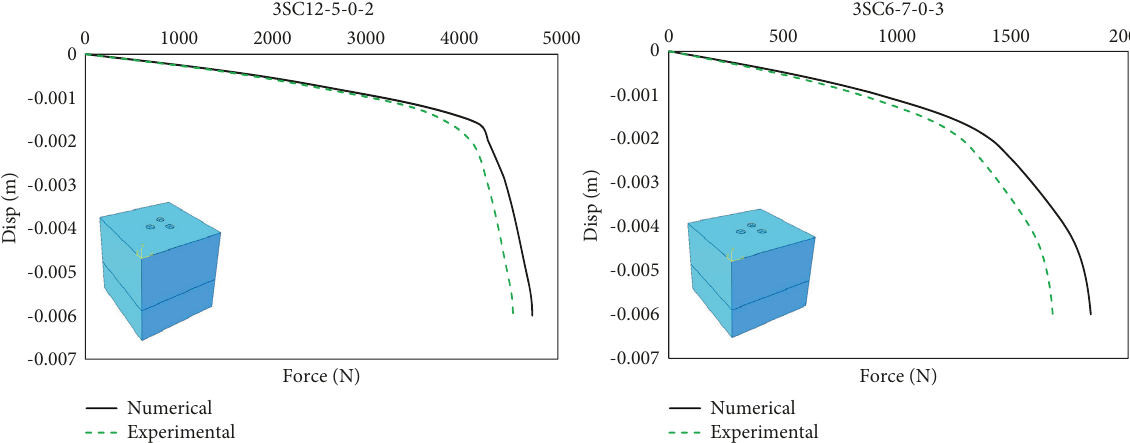
Figure 13: Force-displacement diagram related to model 3SC6-7-0-3 in both numerical and laboratory